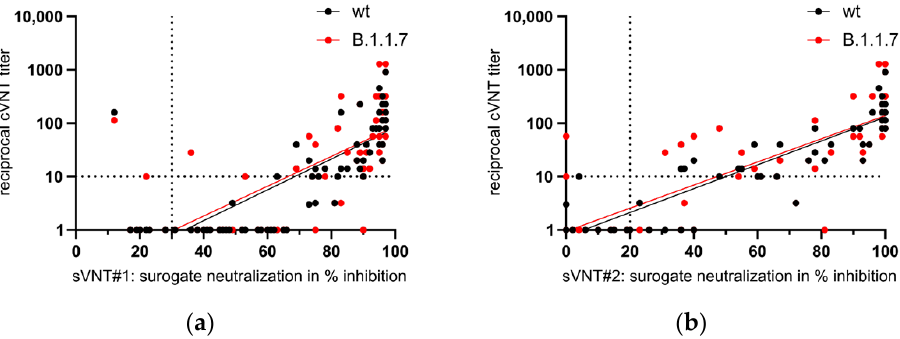
Figure 6. Comparison of the results of the surrogate neutralization tests (sVNT) #1 ( a ) and #2 ( b ) with those of the cell-based neutralization test (cVNT) using a ‘wildtype’ SARS-CoV-2 strain (wt) and a B.1.1.7 strain as antigens. A serum dilution of >1:10 is considered as protective. The decision limits for relevant inhibition of SARS-CoV-2 receptor-binding domain interaction with the human angiotensin-converting enzyme 2 varies between ≥20% (sVNT#2) and ≥30% (sVNT#1). Spearman correlation coefficients were calculated with 0.85 (sVNT#1 vs. cVNT with wt), 0.80 (sVNT#1 vs. cVNT with B.1.1.7), 0.92 (sVNT#2 vs. cVNT with wt), and 0.85 (sVNT#2 vs. cVNT with B.1.1.7), re- spectively. Table 4. Qualitative agreement of results obtained in the cell-based virus neutralization test and of IgG avidities measured in the recom Line assay. Figure 7. Comparison of immunoglobulin G (IgG) avidity to virus-neutralizing titers obtained with the cell-based neutralization test (cVNT) using a ‘wildtype’ SARS-CoV-2 strain (wt) and a B.1.1.7 virus as antigens. The reciprocal geometric mean titer and the 95% confidence intervals are given.